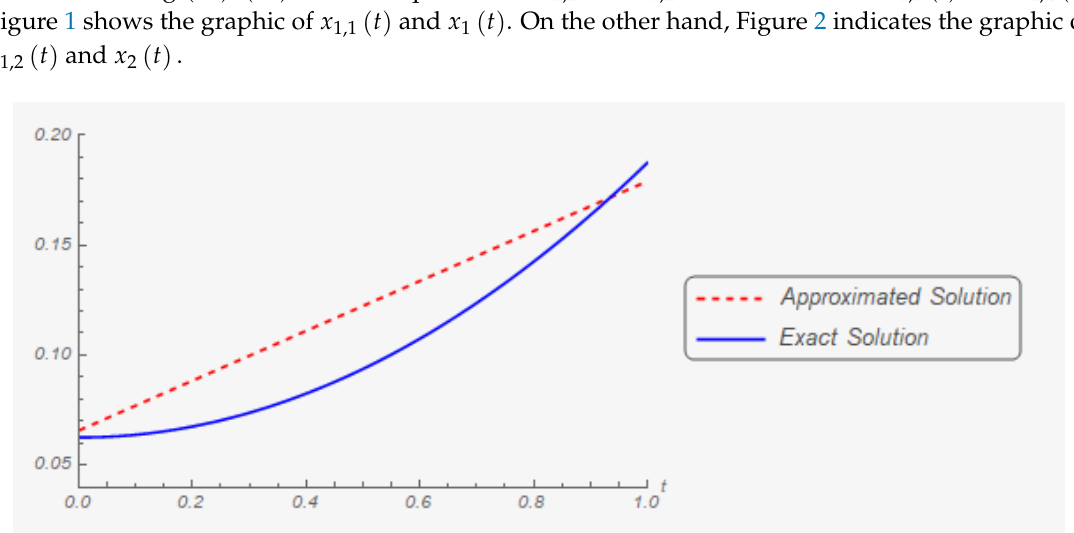
Figure 1. The first component of the exact solution and its first approximation.